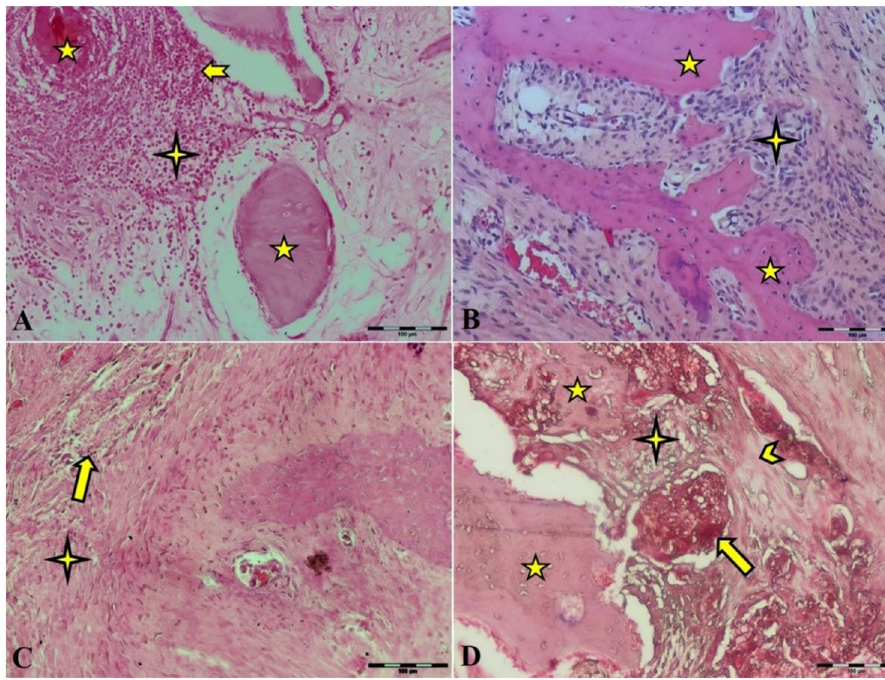
Fig. 5 Microscopic section from the healing site of defect on the 15th day postoperation. A Control group has abundant leukocyte in fi ltration in granulation tissue. B The autograft group shows bone remains. C HA and D TCP- TiO2 materials in the center of the defect. Scant new bone formation is shown in the TCP- TiO2 group (HE × 200). star: remain previous bone; notched arrow: leukocyte in fi ltration; arrow: substitute material; chevron: new bone; 4-point star: granulation